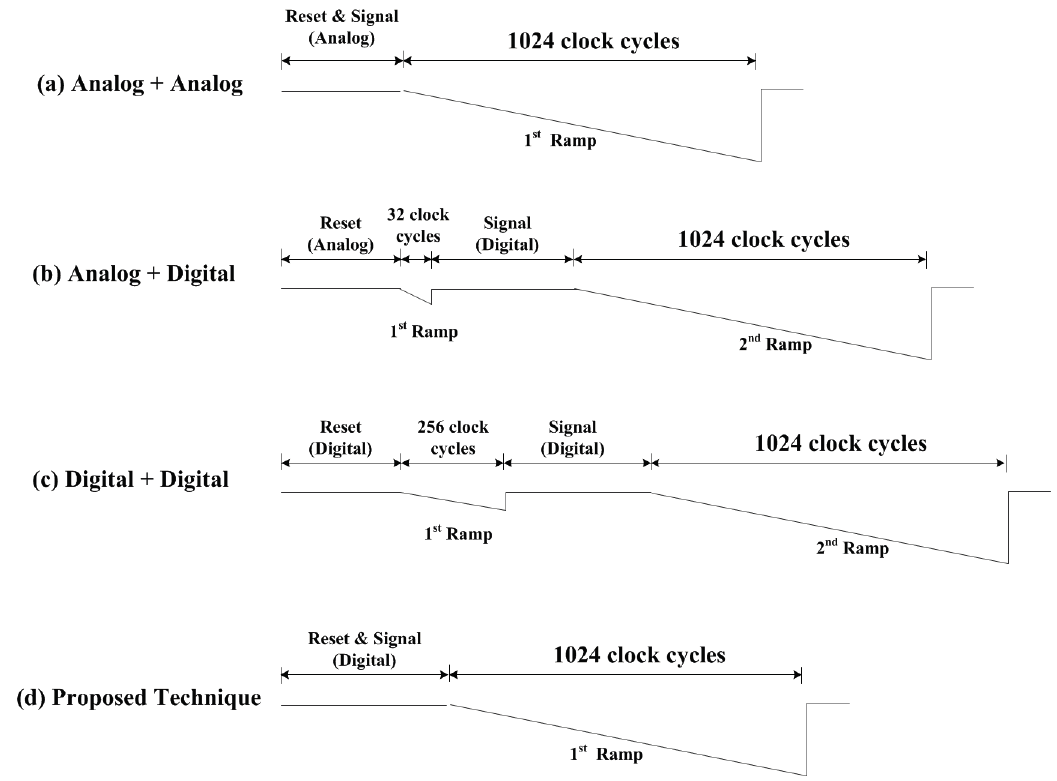
Figure 5. Timing diagram of conventional CDSs and the proposed CDS (10-bit) ( a ) analog reset signal and analog pixel signal (1024 clocks); ( b )analog reset signal and digital pixel signal (32 + 1024 clocks); ( c ) digital reset signal and digital pixel signal (256 + 1024 clocks); ( d ) the proposed digital CDS (1024